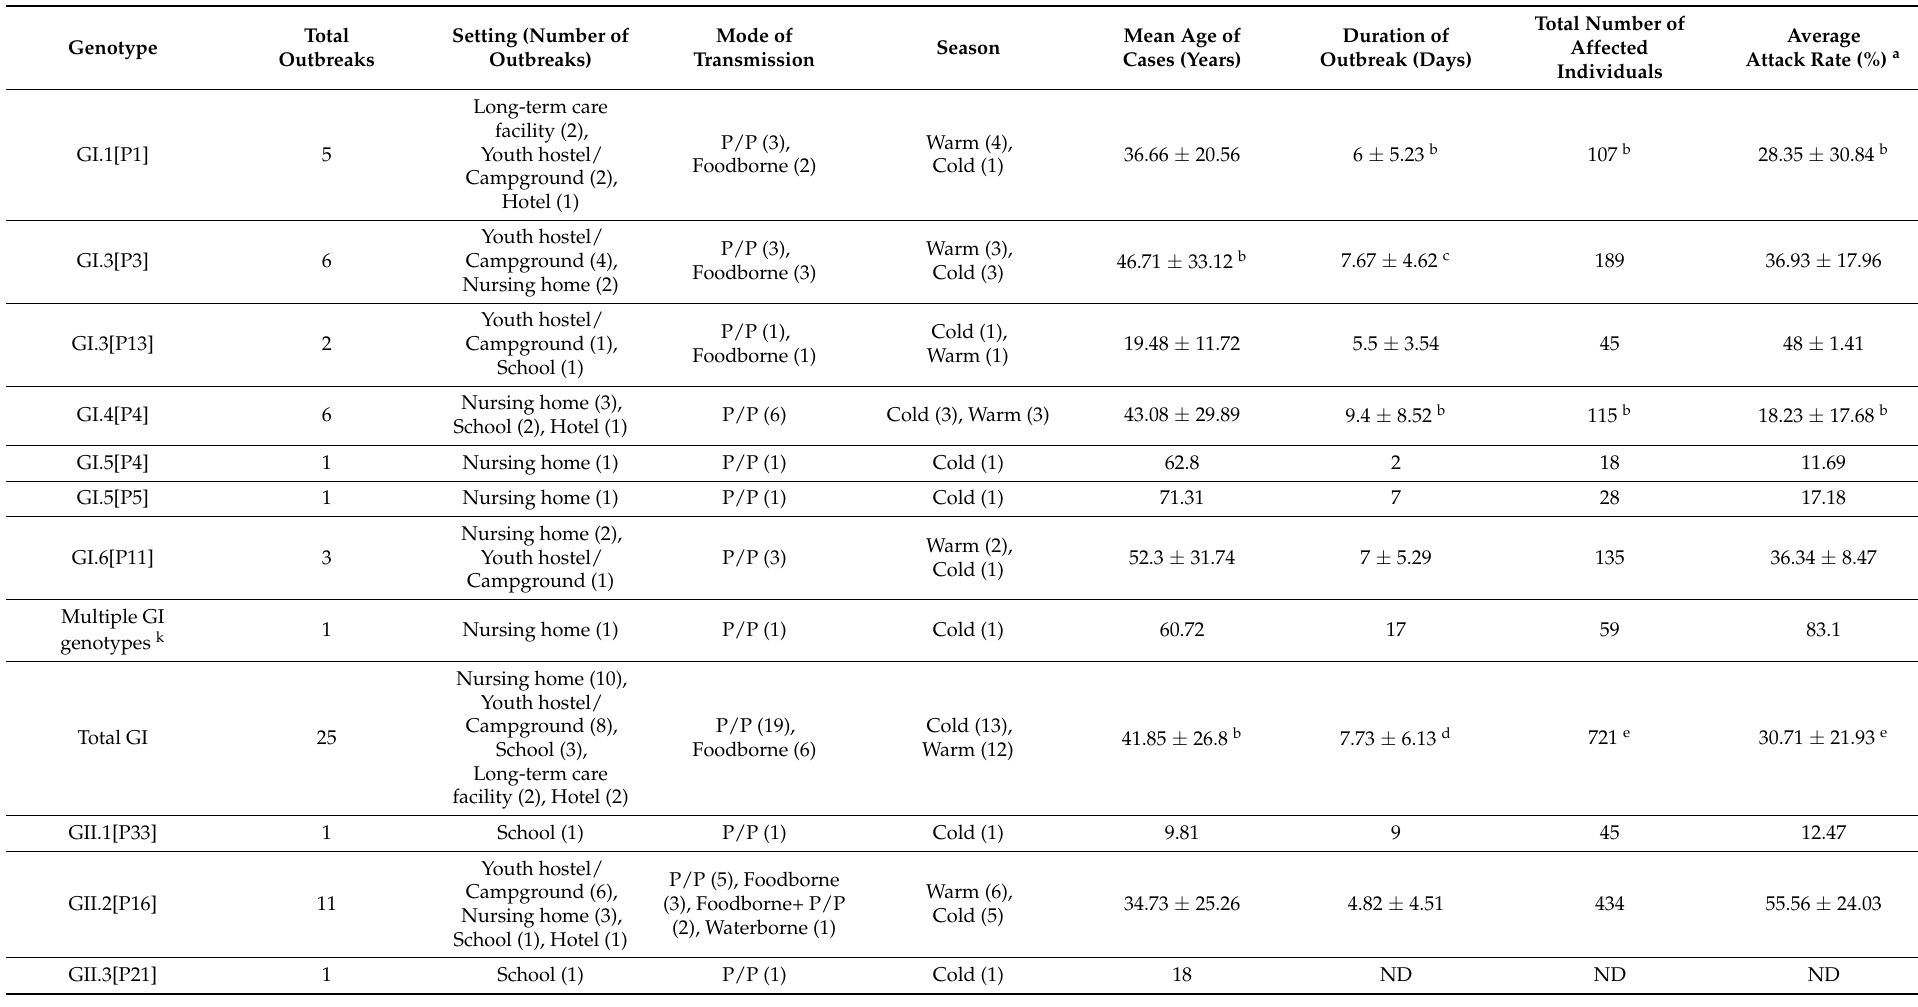
Table 4. Main epidemiological features of the outbreaks included in the study, according to